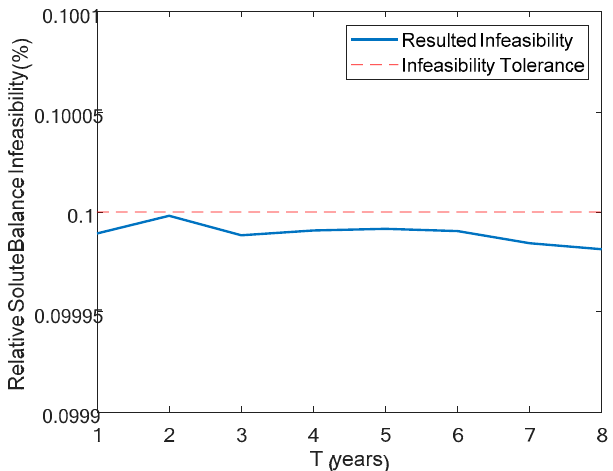
Figure 10. Relative infeasibility using the SOH.